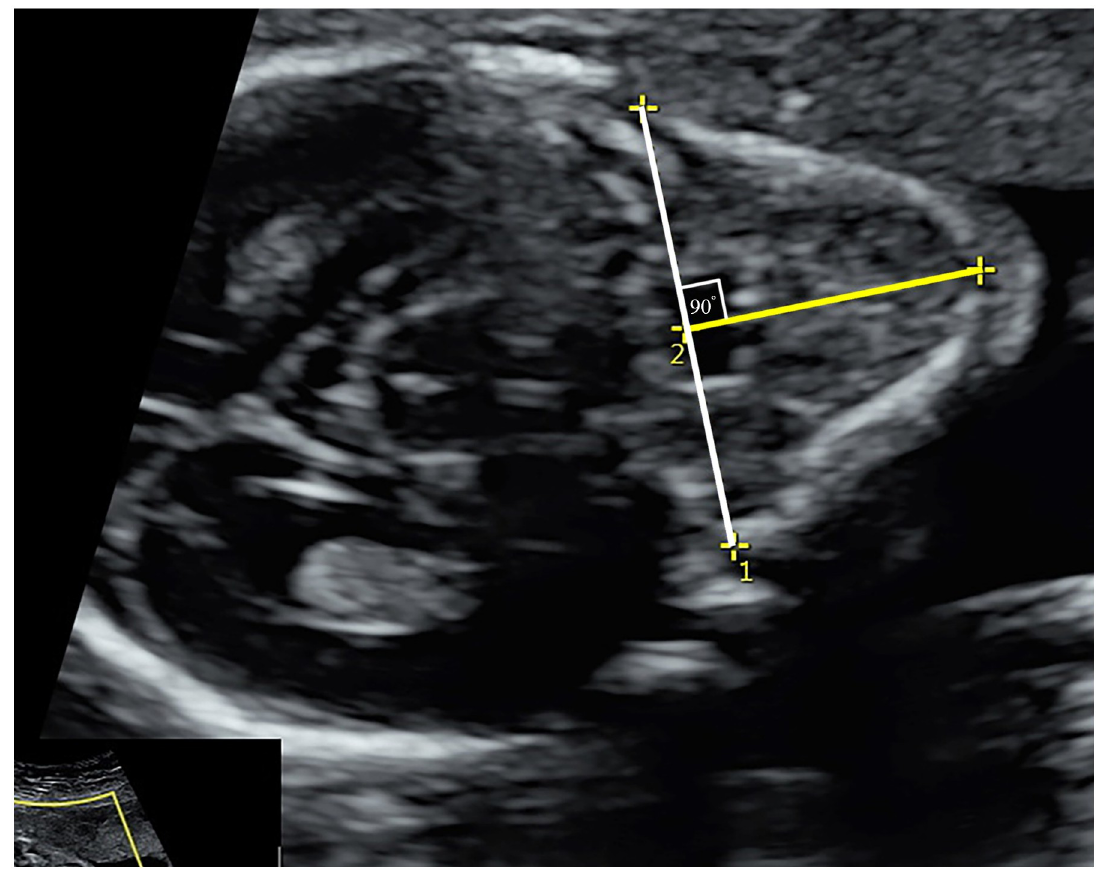
Fig 2. Anteroposterior mandibular diameter (APD) measurement. Jaw index = APD/biparietal diameter x 100.